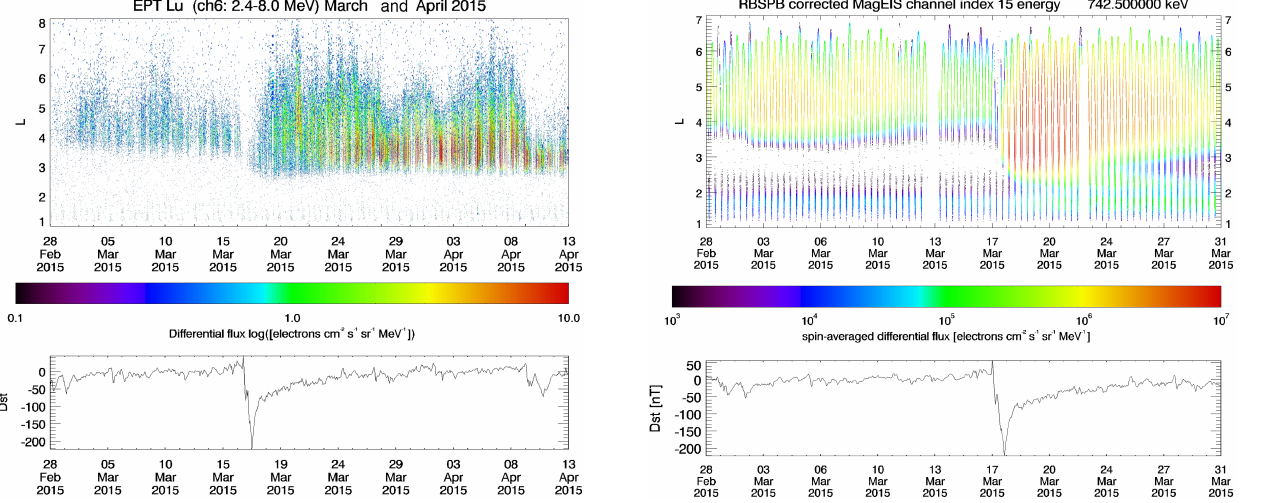
Figure 6. Corrected electron fluxes observed in Channel 742keV of Van Allen Probe/MAGEIS as a function of L between 28 February and 31 March